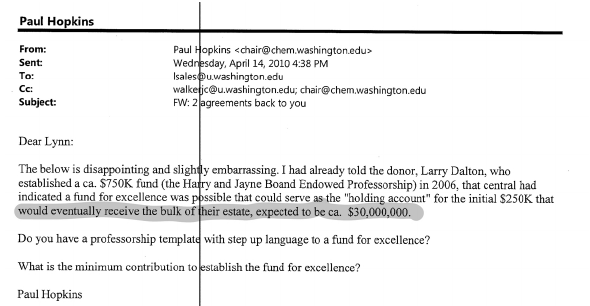
Figure 8: Where are we going to put $30,000,000? Email from P. B. Hopkins to L. Sales, 2010 Apr 14.